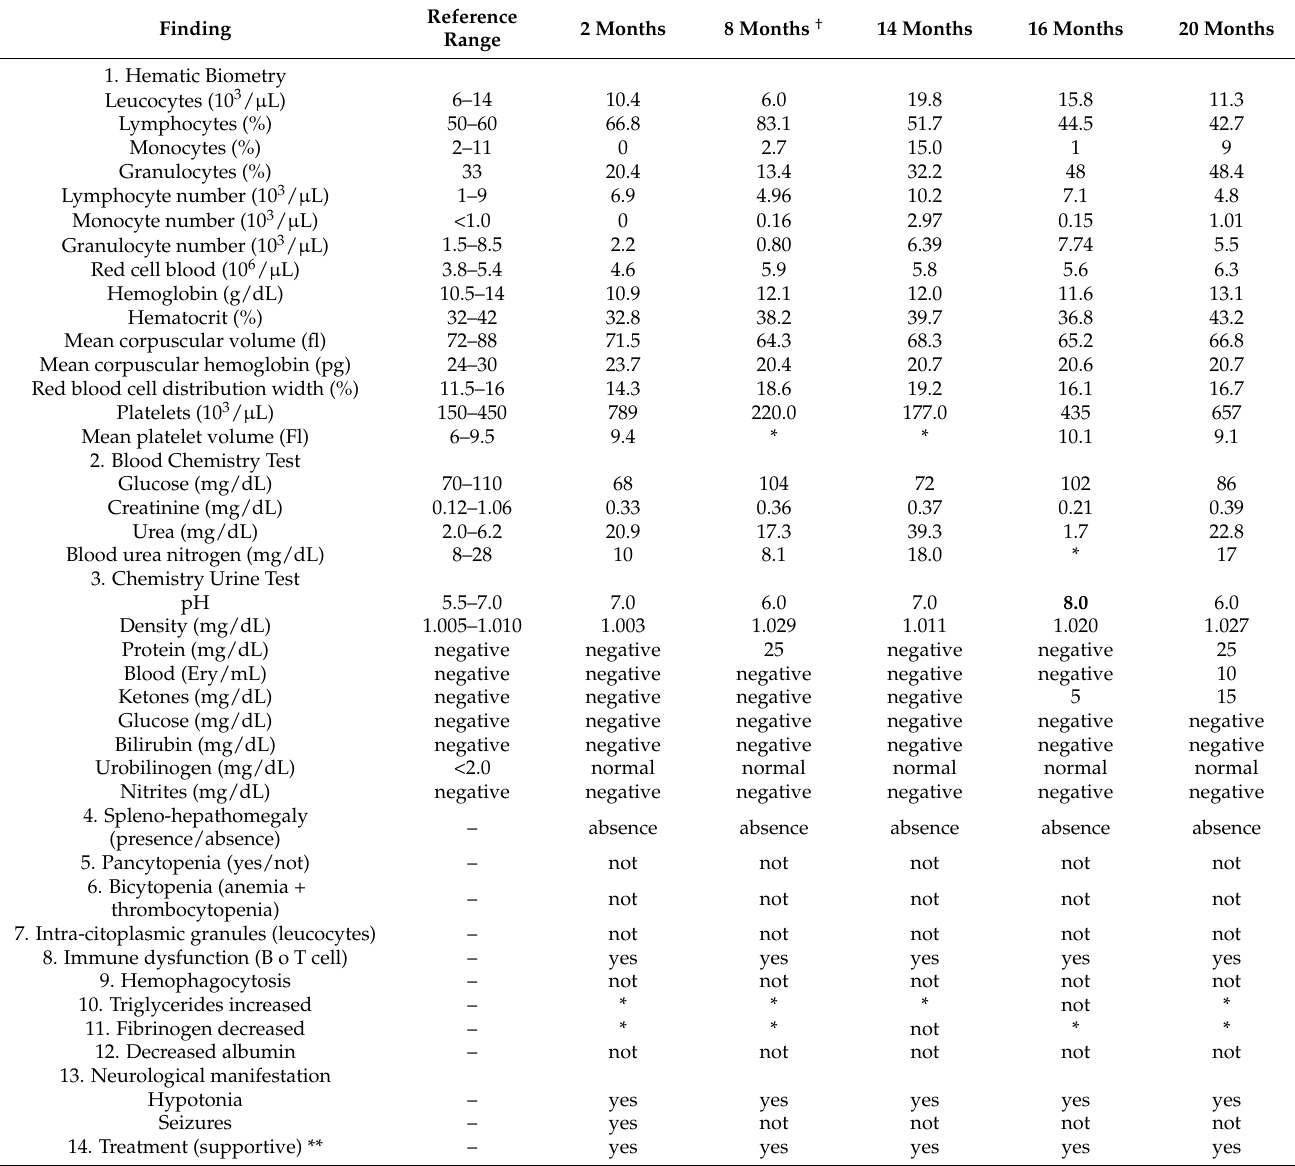
Table 3. Laboratory findings and monitoring of the clinical course of the